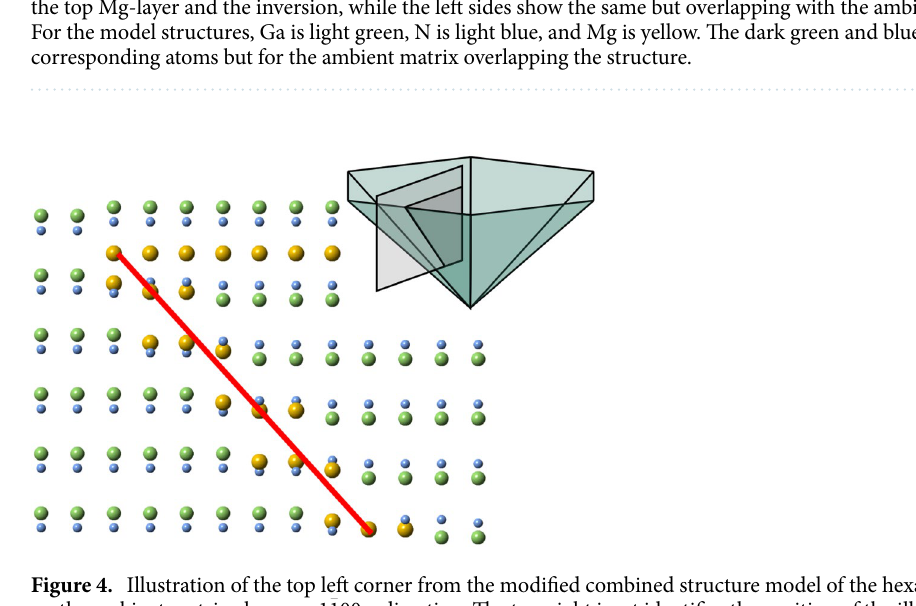
Figure 4. Illustration of the top left corner from the modified combined structure model of the hexagonal PID vs. the ambient matrix along a < 1 ¯ 100 > direction. The top-right inset identifies the position of the illustration in the PID. The red line outlines a { 11 ¯ 23 } facet. In the model structure, Ga is light green, N is light blue, and Mg is